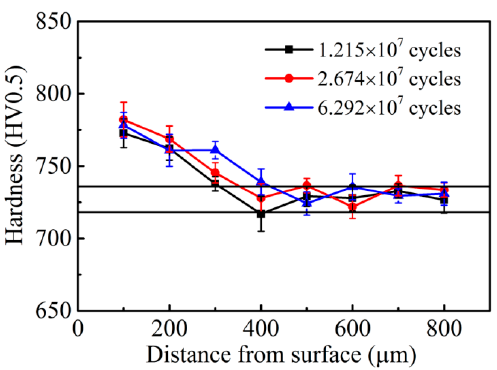
Figure 9. Hardness distributions of the HC steel after different RCF testing cycles (the two horizontal lines show the hardness ranges of the initial microstructure).